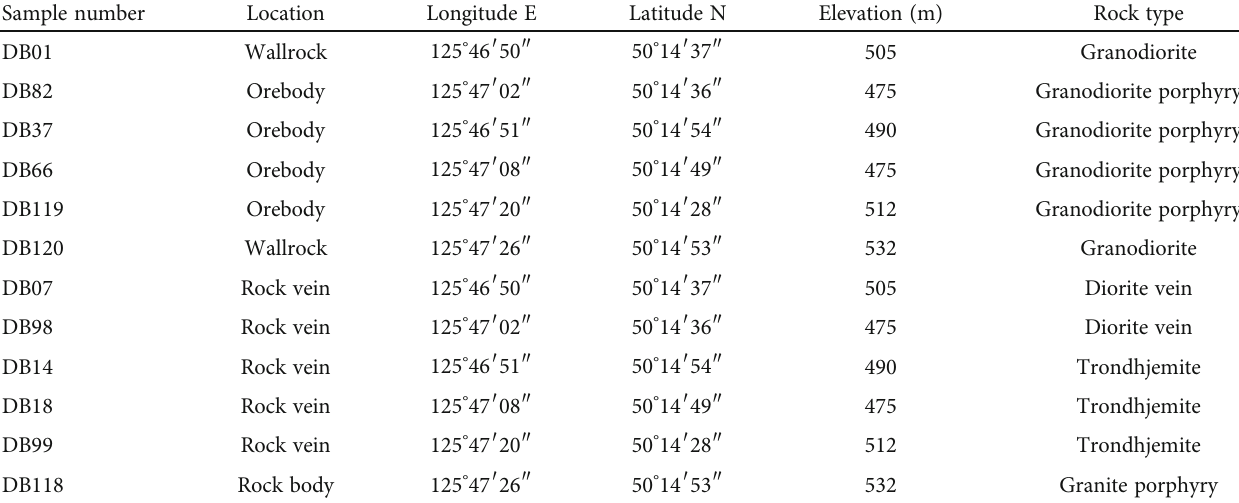
Table 1: Sample description of the Duobaoshan copper